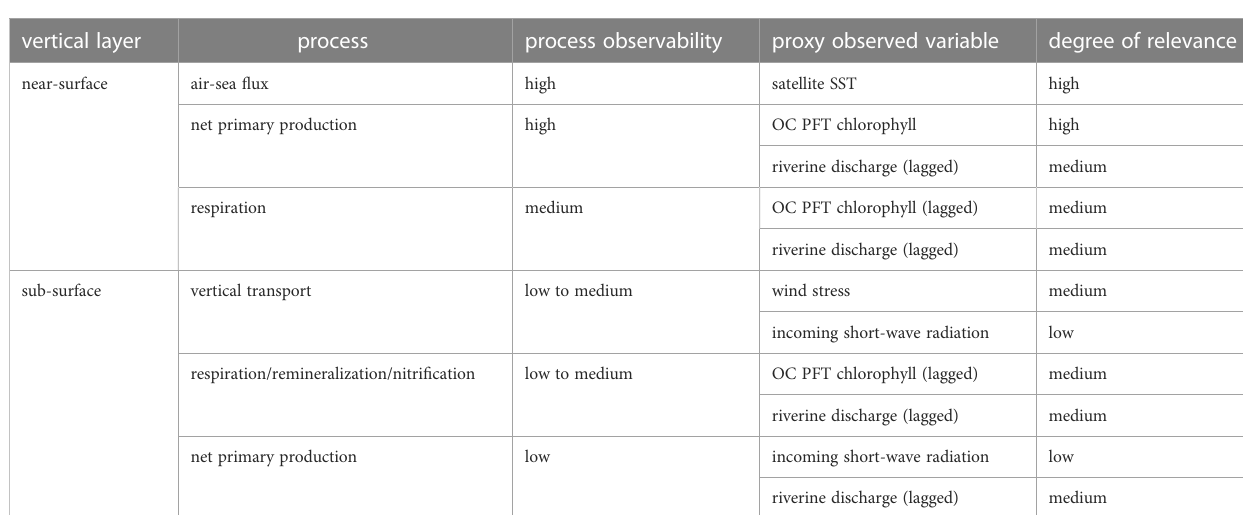
TABLE 1 The list of processes that impact oxygen within a fi xed shelf sea location (in a 1D water-column) both near the surface and deeper beneath the surface